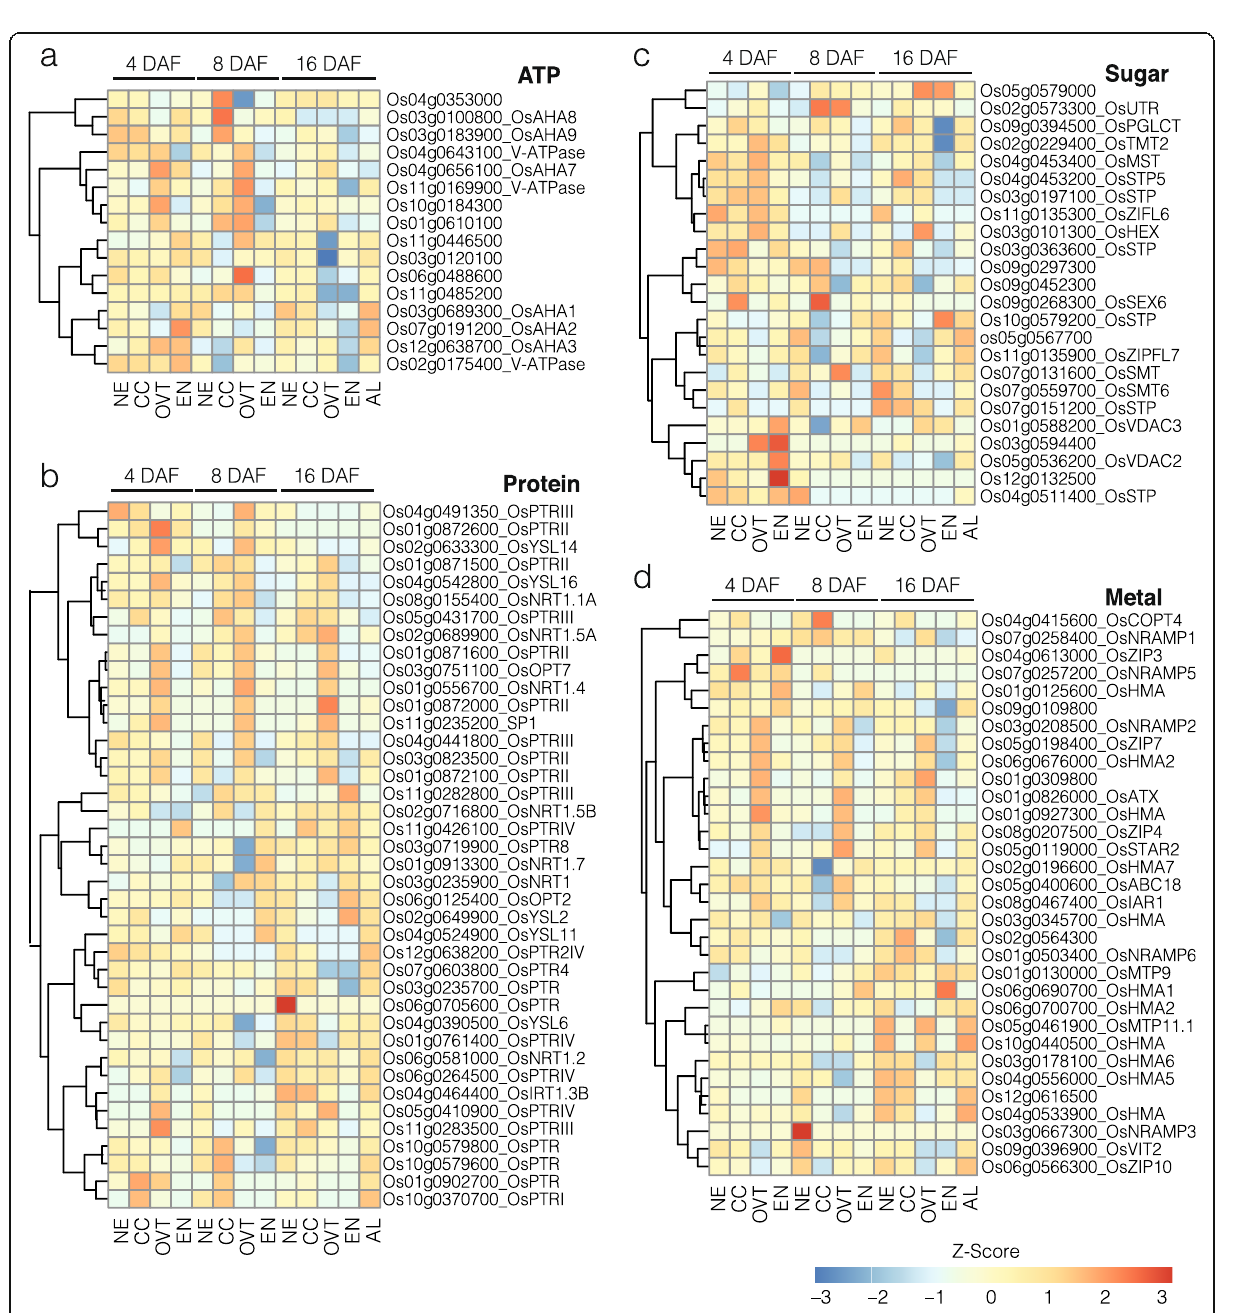
Fig. 6 Expression profiles of DEGs related to transporters. a Genes involved in ATP synthesis and transport. b Genes involved in protein transport. c Genes involved in metal transport. d Genes involved in sugar transport. The gene-normalized signal intensities are shown in the heat maps using Z-Scores. DAF: days after